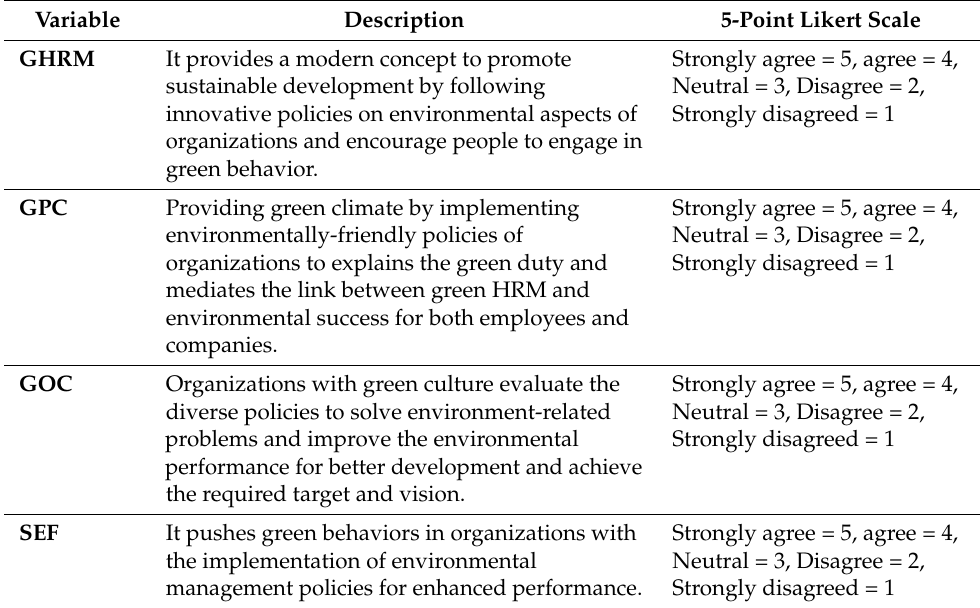
Table 1. Variables with the description used under the present study.